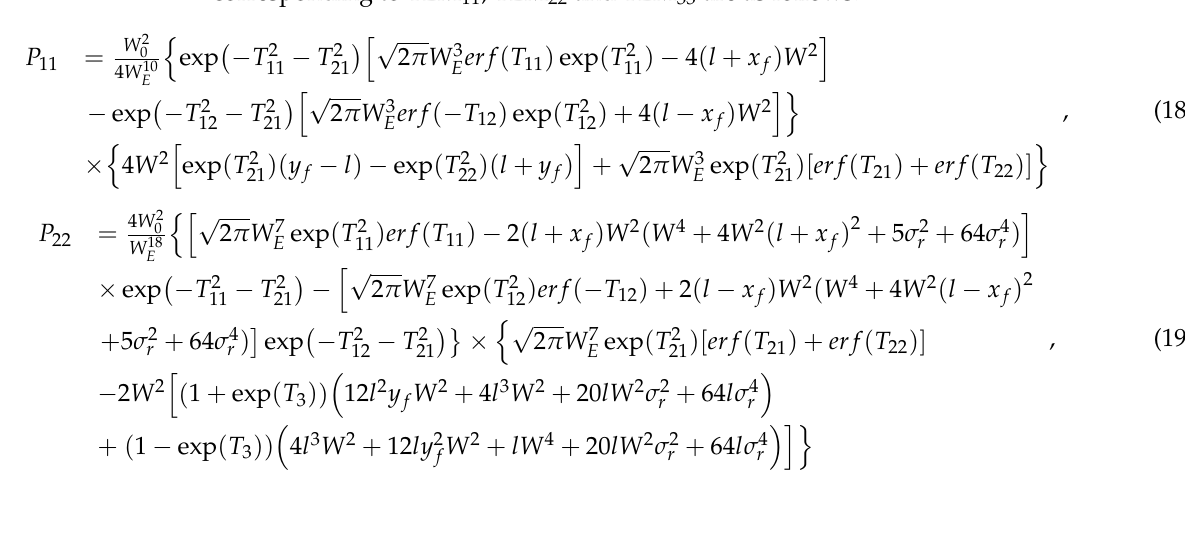
Figure 7. Array receiving for HG beam. ( a ) TEM 11 , ( b ) TEM 22 and ( c ) TEM 33 . The average received power under the pointing error can be formulated by integrat- ing the average irradiance under the pointing error of the receiving aperture. Based on Equation (5), the average received power for the HG beam under the pointing error is formulated as follows: